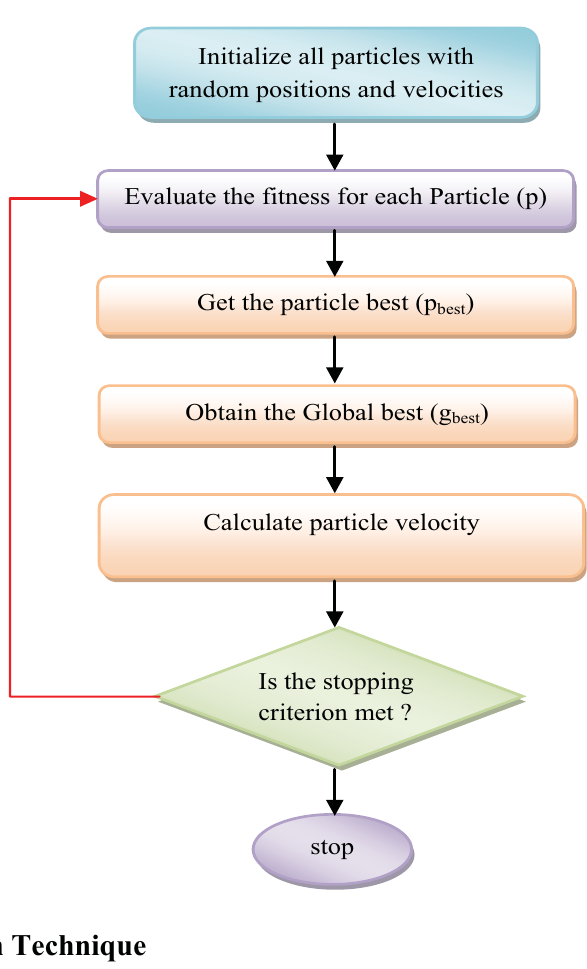
Figure 2. The basic PSO